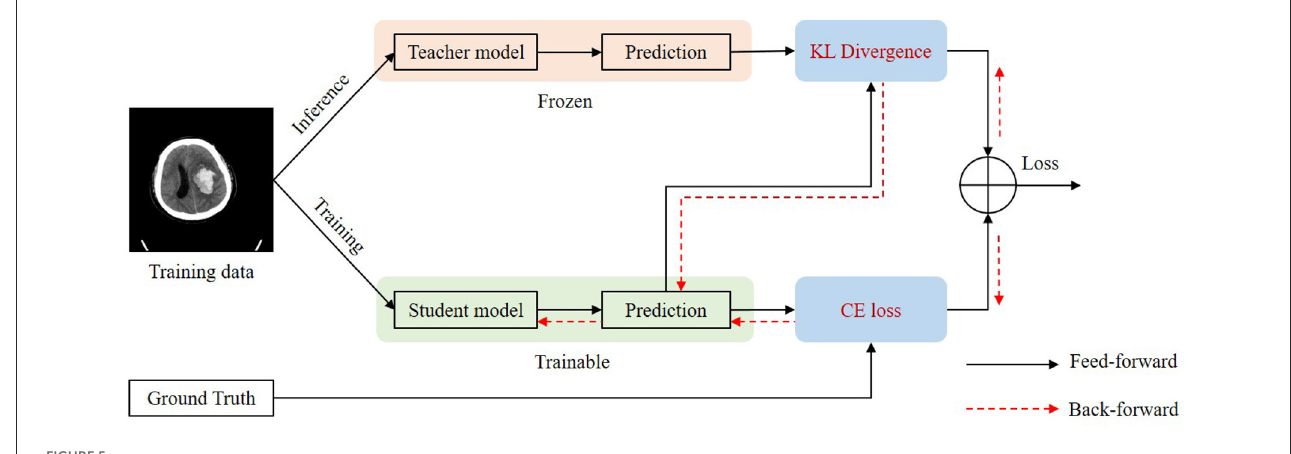
FIGURE5 Illustration of self-knowledge distillation.